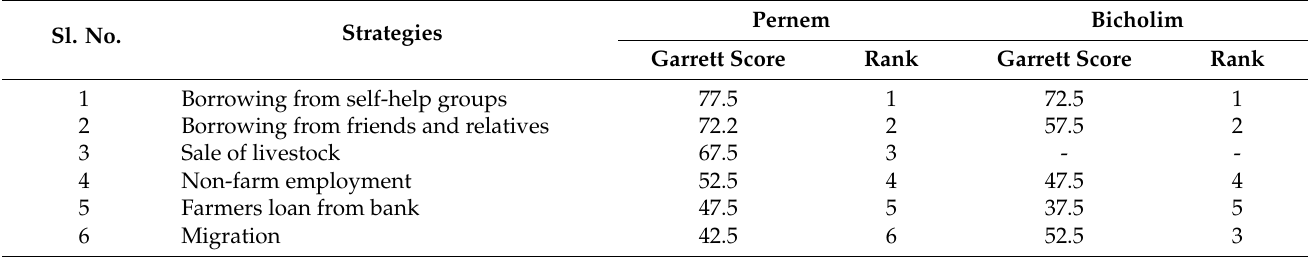
Table 3. Income management strategies practiced by farmers.